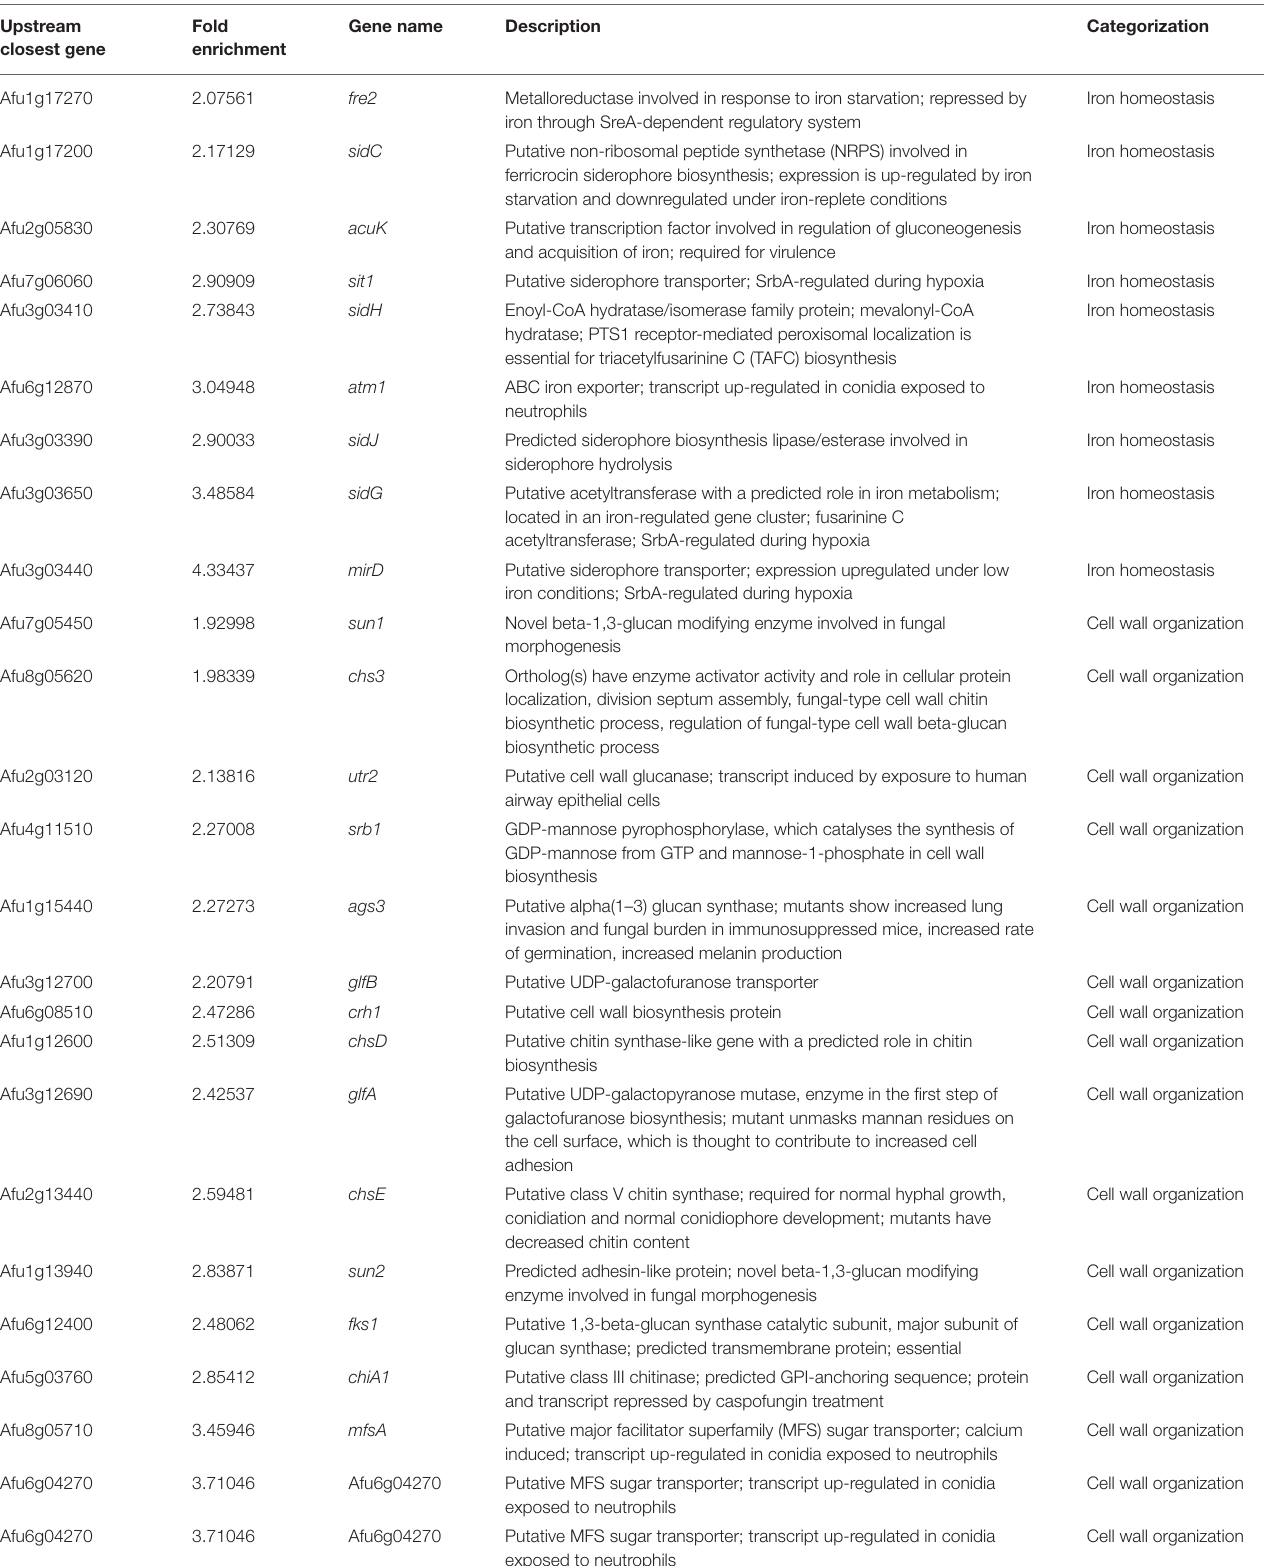
TABLE 1 | List of the main ZnfA:3xHA target genes identified in the ChIP-seq analysis enriched in the caspofungin exclusive condition. Upstream closest